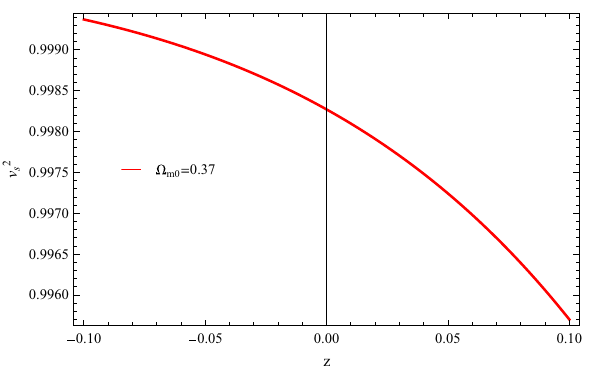
Fig. 14 Plot of v 2 s versus z at Hubble horizon with Bekenstein entropy